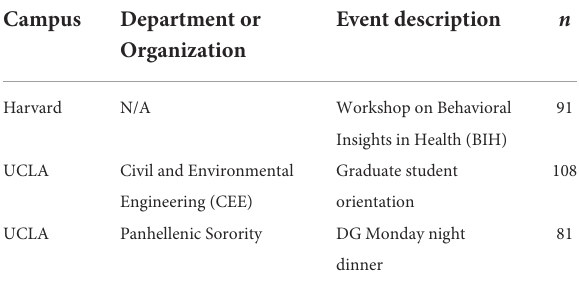
TABLE 1 Details for three catered events included in